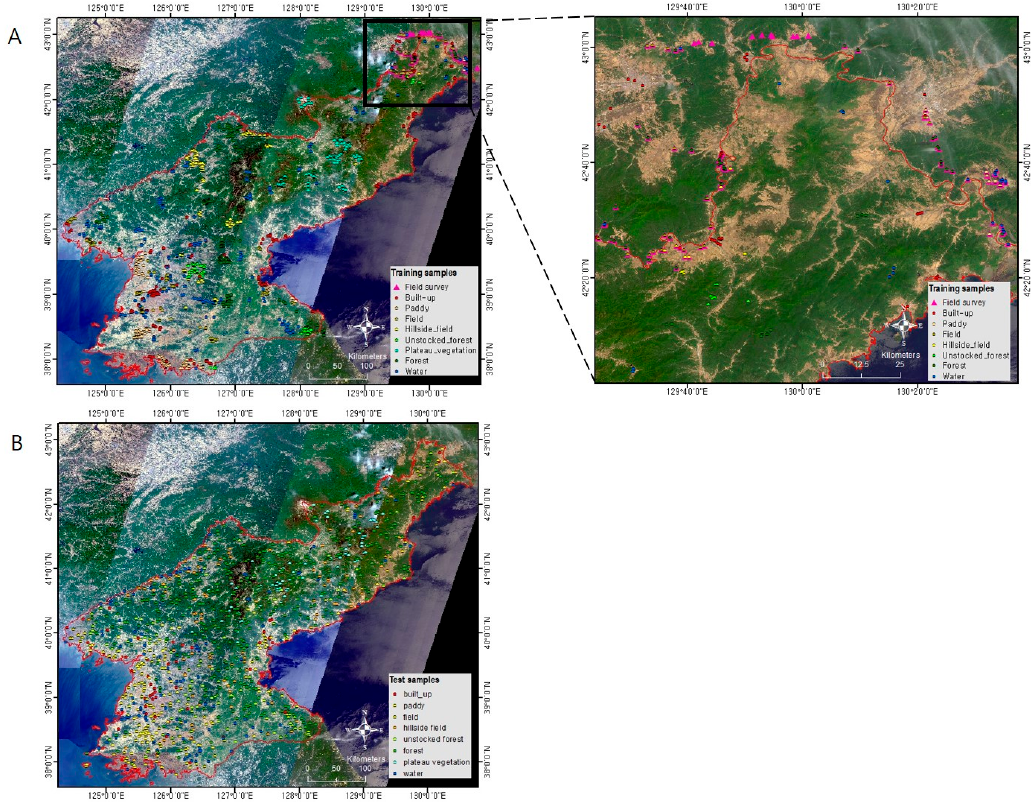
Figure 3. Independent training samples (1660 points) ( A ) were collected regarding eight land cover classes in North Korea with a field survey; the 999 test points ( B ) used for the classification accuracy assessment were selected by random sampling. The displayed images are Landsat 8 OLE products. Table 1. Classification types and visual interpretation used for identifying training samples in satellite images.